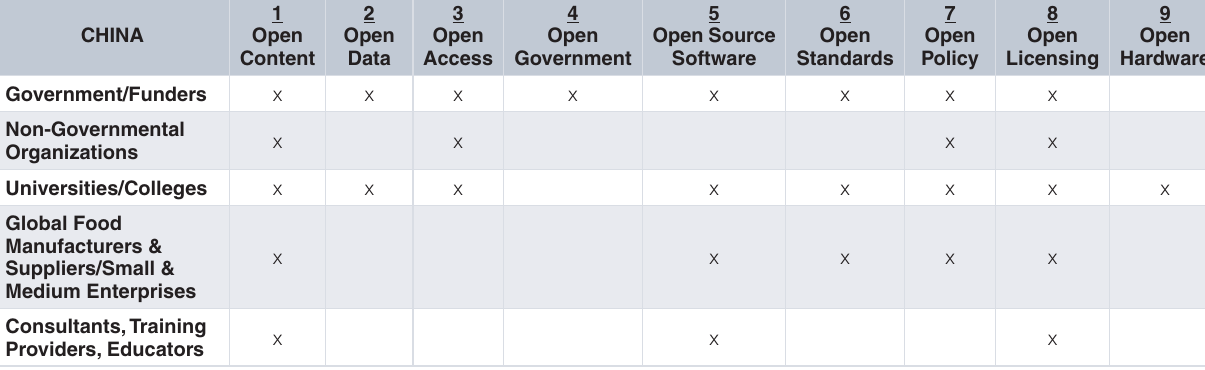
Table 1 indicates the potential starting points for various stake- holder groups in China in using the nine different types of open practices. For example, government and funders are poised to make use of eight of the nine open practices (open content, open data, open access, open government, open sources software, open policy and open licensing), whereas the use of open hardware, which is a relatively new form of open practice, is most likely to be initiated by universities and colleges.